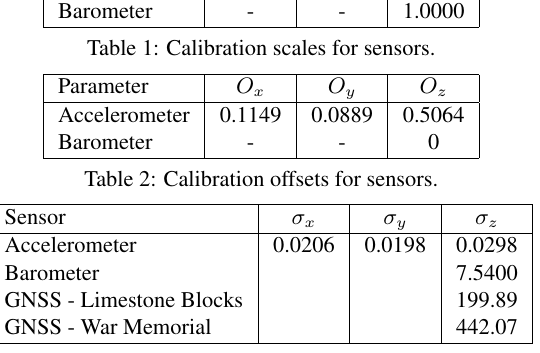
Table 3: Sensor standard deviations after calibration To give an idea of scale, a standard deviation for the barometer of 7.54 Pa in Table 3 results in approximately 0.63 m of elevation at the standard atmospheric pressure of 100 kPa.